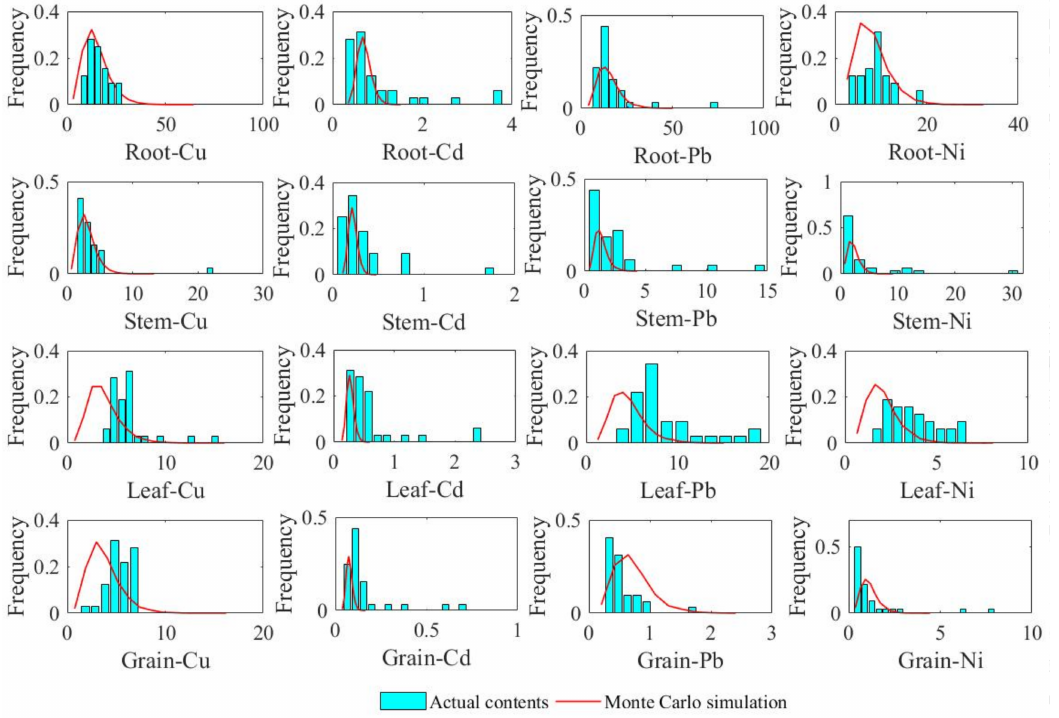
Figure 8. Comparison between Monte Carlo simulation and actual measurement